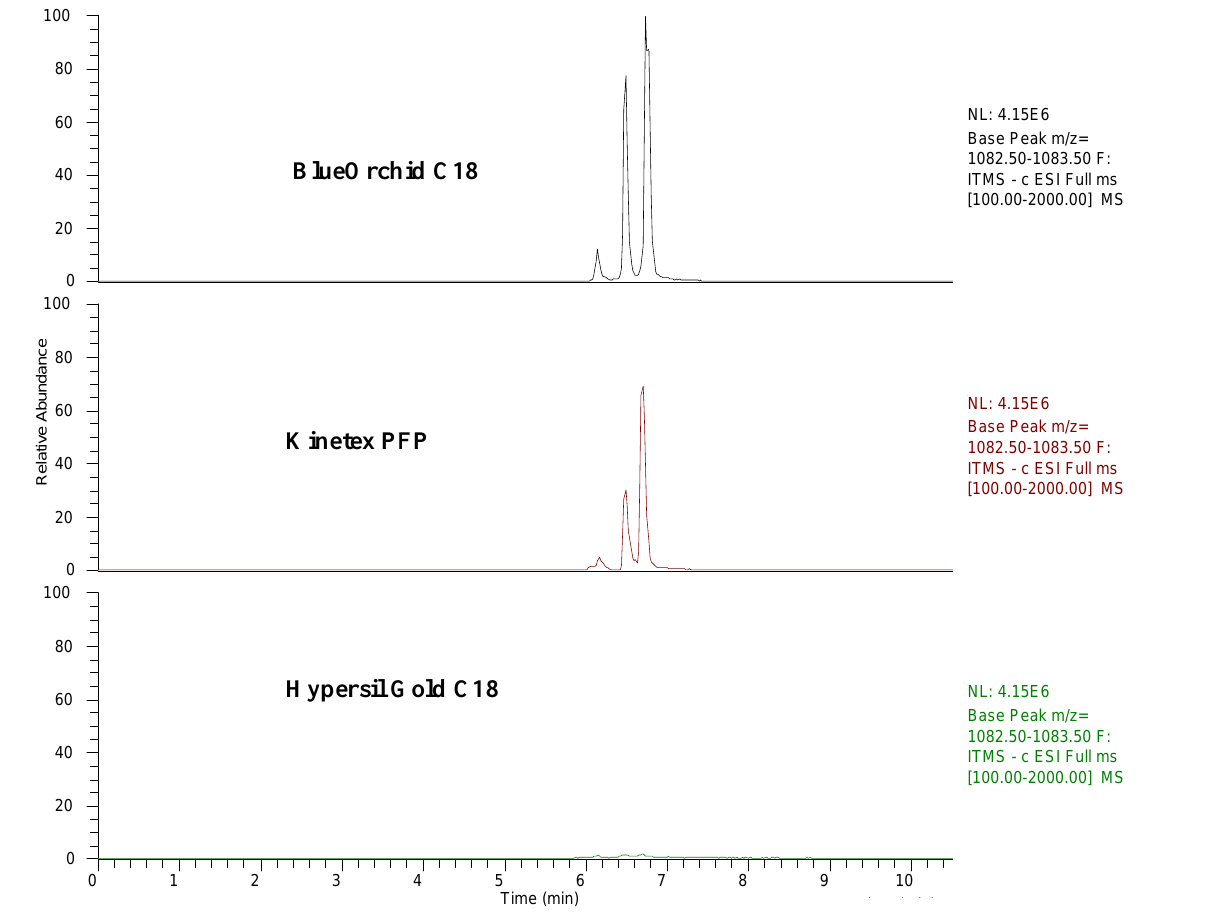
Figure 5. Chromatograms of punicalagins in full MS Scan of the three analytical